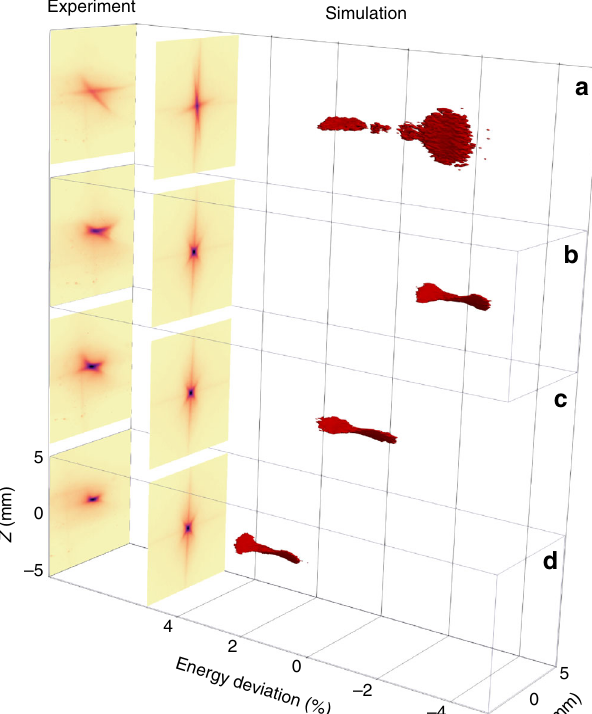
Fig. 6 Transverse pro fi le of the electron beam for different quadrupole strengths. Electron beam optics focusing on the screen downstream the undulator without slit, for the 176 MeV reference case. Experimental, simulated pro fi les and associate modelled phase-space plot a mismatched case, c well-focused case with a 1.5% correction of QUAPEVA 2, variation of the gradients of all the quadrupoles (permanent magnet and electromagnetic) by − 2% ( b ) and + 2% ( d )